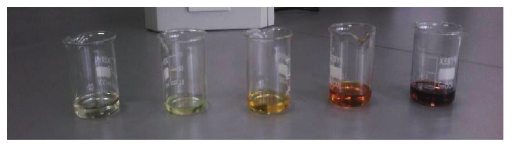
Figure 1: Color Changes in Ag-nPAA composite